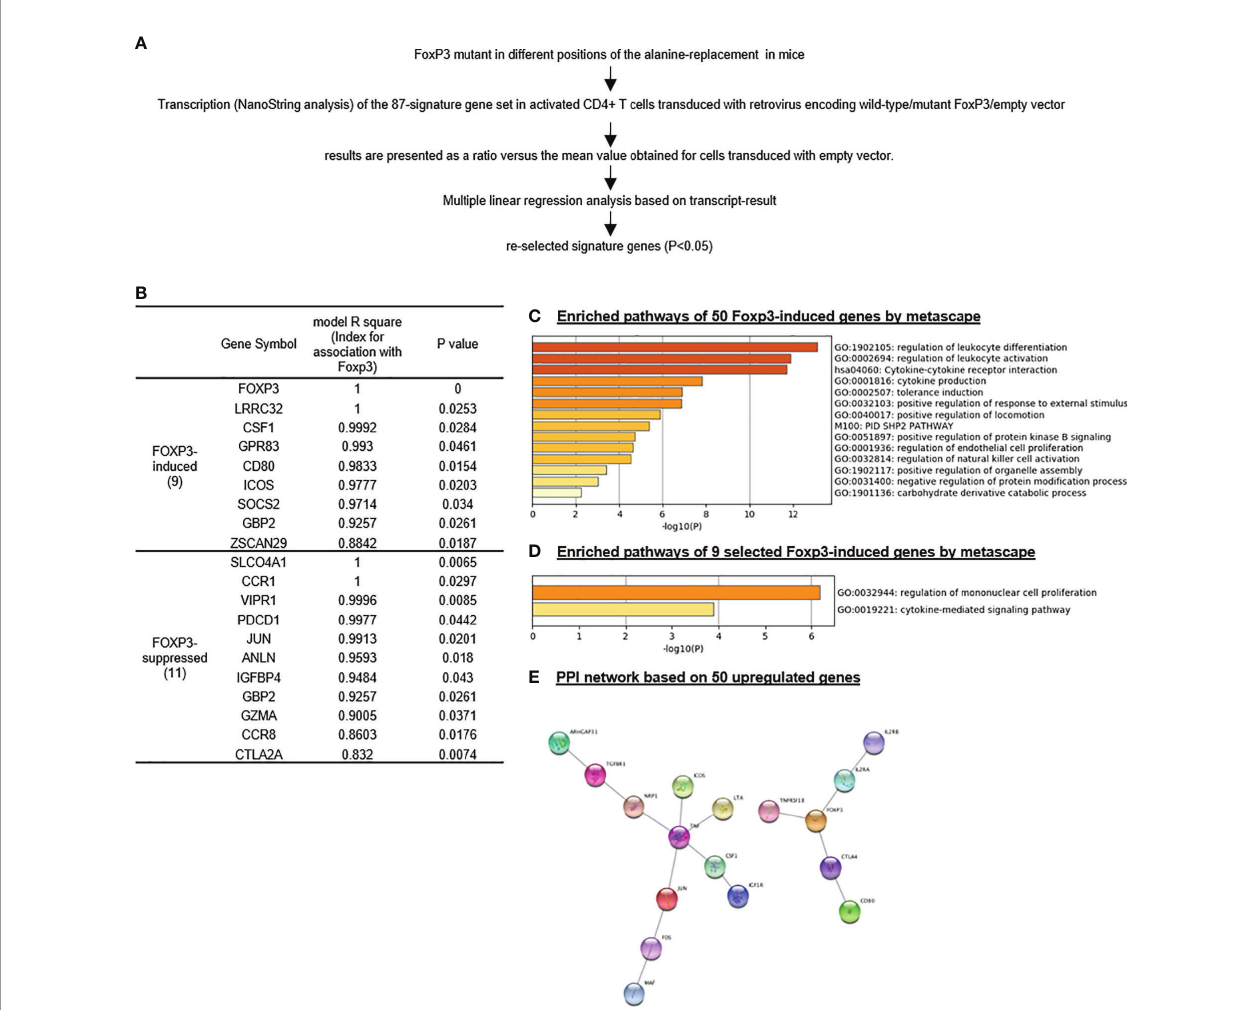
FIGURE 2 | Foxp3 reliably promotes “ monocyte ” proliferation signaling and suppresses MAPK signaling in Treg; and nine out of 50 Foxp3-induced genes are identi fi ed as most reliable Foxp3-induced genes. We re-analyzed the Treg signature gene set, which was tested by Nanostring using Treg extracted from spleen on Foxp3 mutant mice (PMID: 28892470) and re-selected Treg signature gene set based on our re-analysis. (A) fl ow chart of Treg signature gene set re-selection by multiple linear regression based on their expression levels according to Nanostring. (B) To identify most closely related genes with FOXP3, we identi fi ed only 20 out of total 87 (50 Foxp3-induced and 37 Foxp3-suppressed genes) signature genes whose expression is consistent with that of Foxp3 by statistic analysis based on the expression result of Nanostring in this paper, either positively or negatively; (C – E) Enriched pathways by the original gene set and selected gene set according ot metascape analysis showed great difference, indicating other mechanism along with Foxp3 modulated Treg homeostasis and shape Treg signature. Protein-Protein Interaction (PPI) by App String in Cytoscape Platform identi fi ed that Tnf and Foxp3 were two central molecules of 50 upregulated signature genes; interaction of chemokine and chemokine receptors was one of the basic network in 37 downregulated signature genes. (Original results for Nanostring was downloaded from Supplementary Table 4